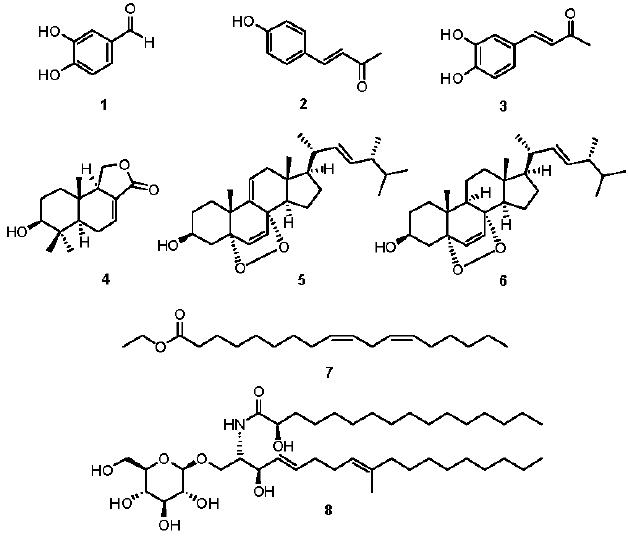
Figure 2. Chemical structures of compounds 1 – 8 .